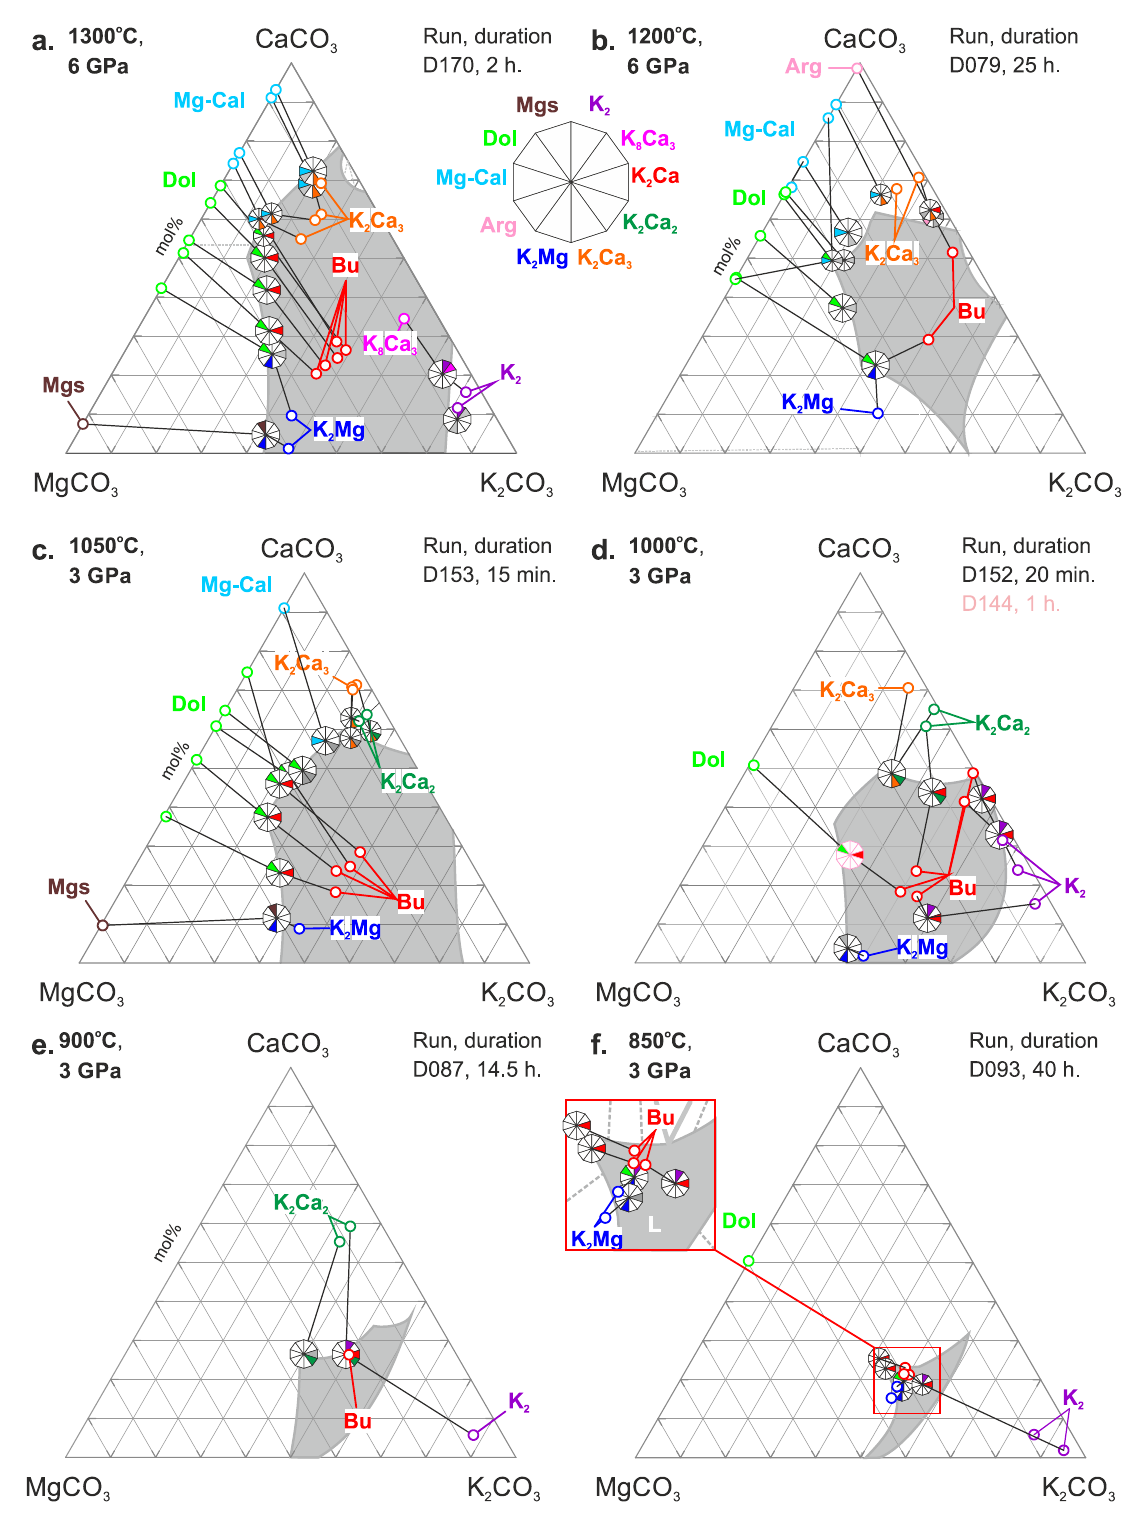
Figure 2. Compositions of quench phases of the melt from the K 2 CO 3 −CaCO 3 −MgCO 3 at 6 ( a , b ) and 3 ( c – f ) GPa. K 2 —solid solution of CaCO 3 in K 2 CO 3 ; Bu—K 2 Ca(CO 3 ) 2 bütschliite; K 2 Ca 2 —K 2 Ca 2 (CO 3 ) 3 ; K 2 Ca 3 —K 2 Ca 3 (CO 3 ) 4 ; Arg—aragonite; Mg-Cal—Mg-bearing calcite; Dol—dolomite; Mgs—magnesite. Gray polygons indicate the bulk composition of the melt. Colored segments indicate observed phases by SDD-EDS. Colored circles indicate the composition of quench phases, measured by EDS. The liquidus fields are shown in gray color.